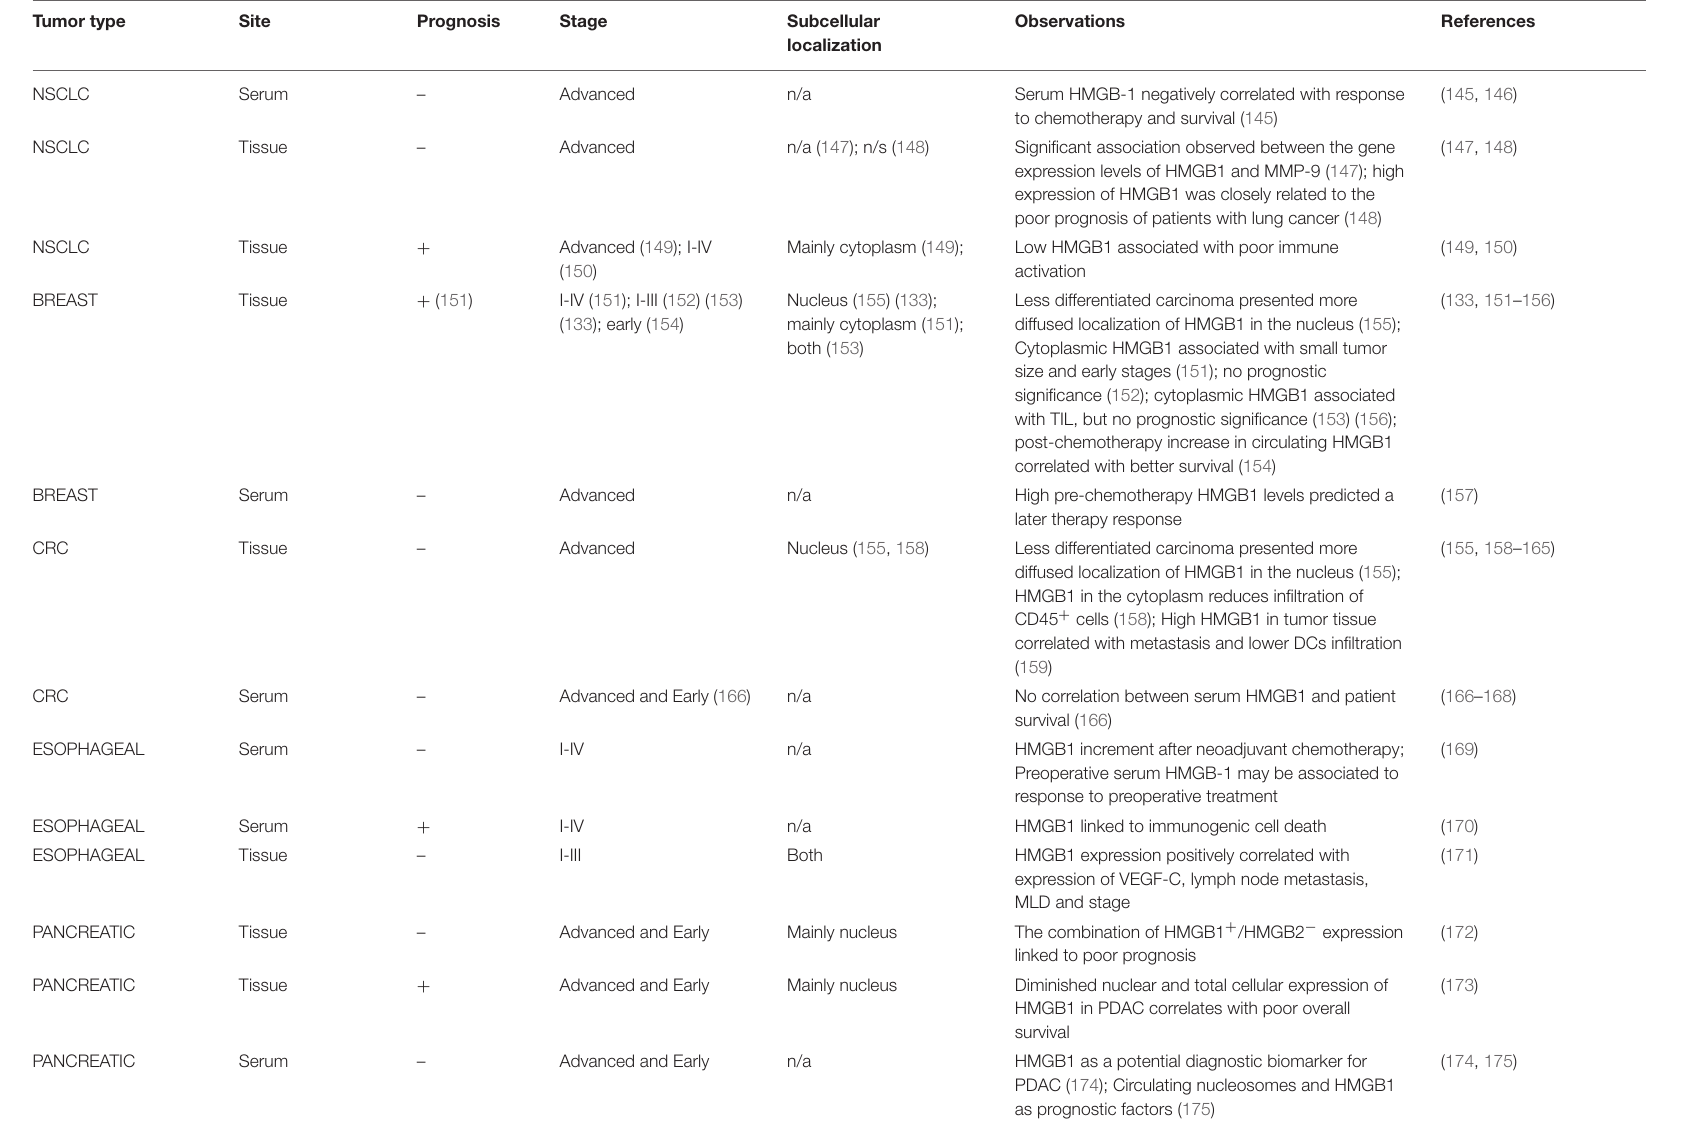
TABLE 1 | HMGB1 expression and subcellular localization in epithelial human